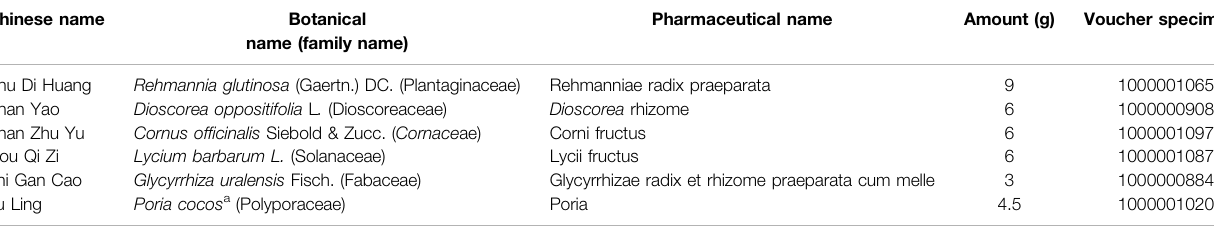
TABLE 3 | The herbal composition of Zuogui.